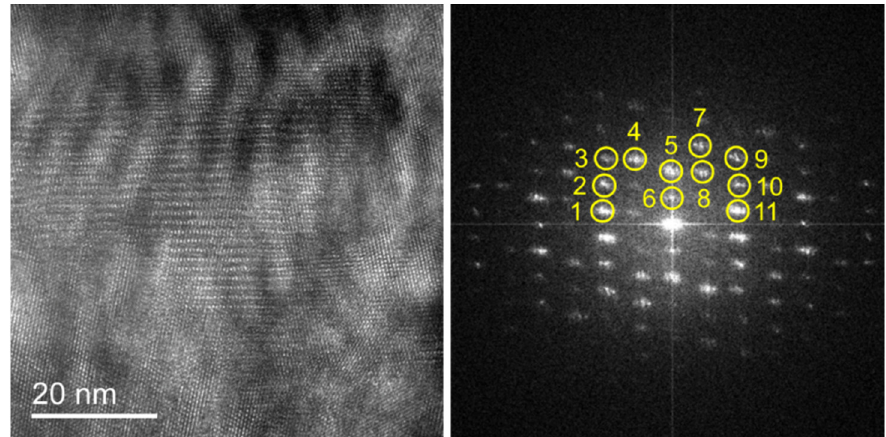
Figure 14. HRTEM image and its corresponding diffraction spectrum in the observation region of TGO at 150 °C.